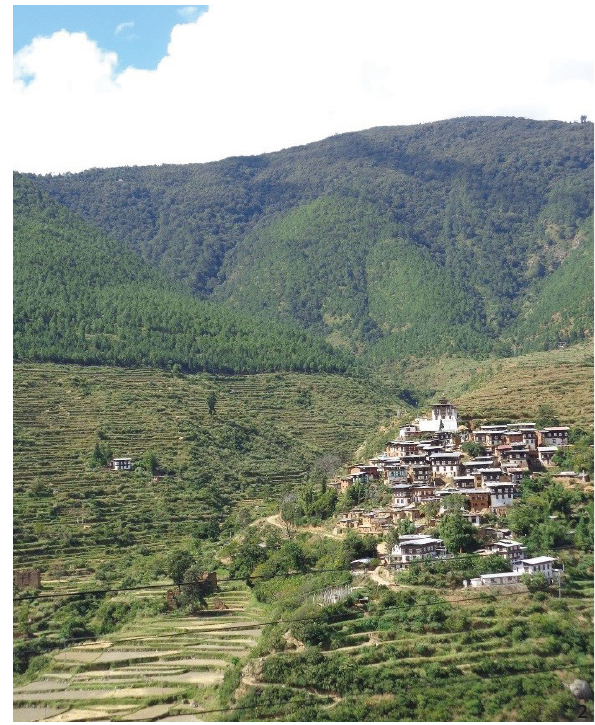
Figure 2 Cultural Landscape of Rinchengang Historic Settlement in Wangduephodrang Dzongkhag (Bhutan) (Source: Roland Chih-Hung Lin).